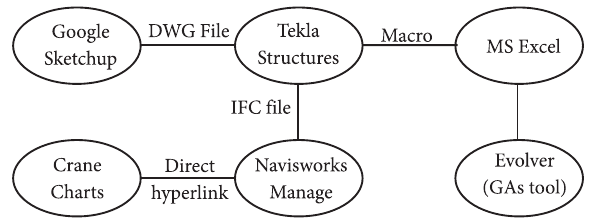
Fig. 1. Connectivity between different components